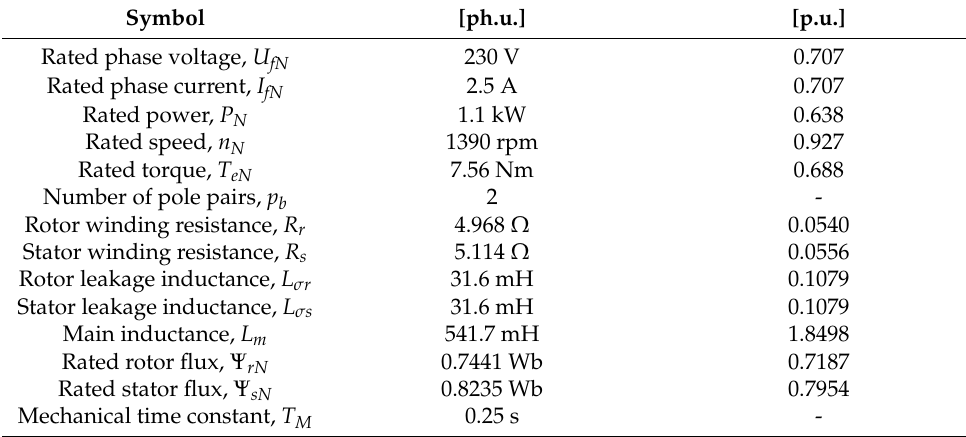
Table A1. Rated parameters of the tested induction